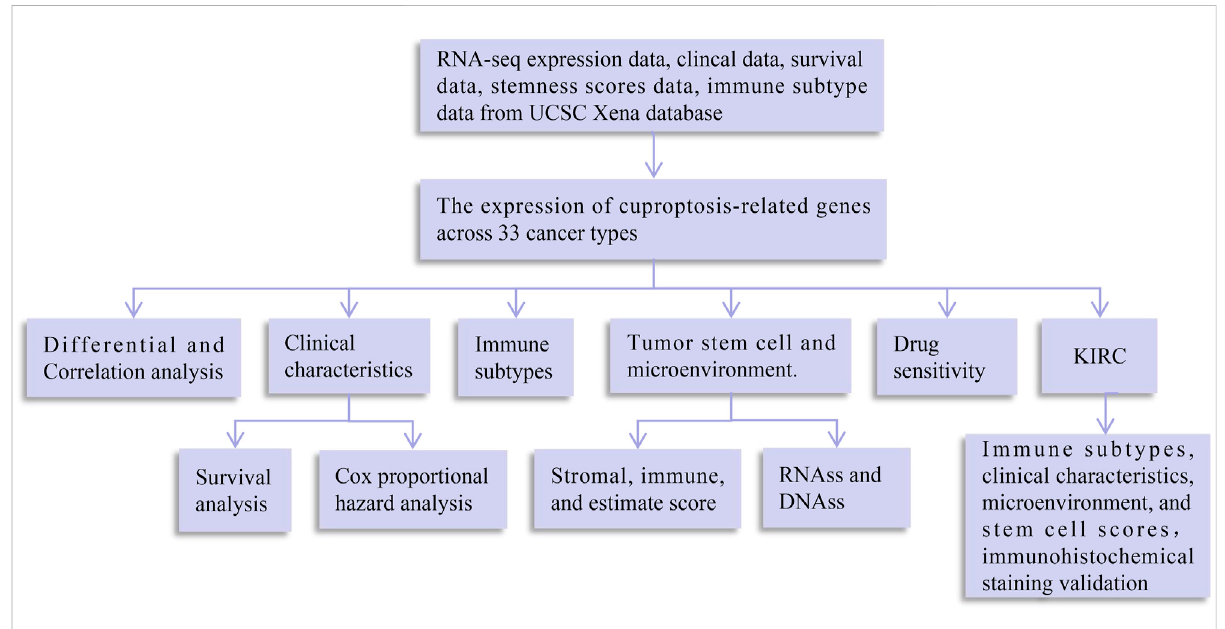
FIGURE 1 Flowchart of pan-cancer analysis in cuproptosis-associated genes. DNAss, DNA stemness score; RNAss, RNA stemness